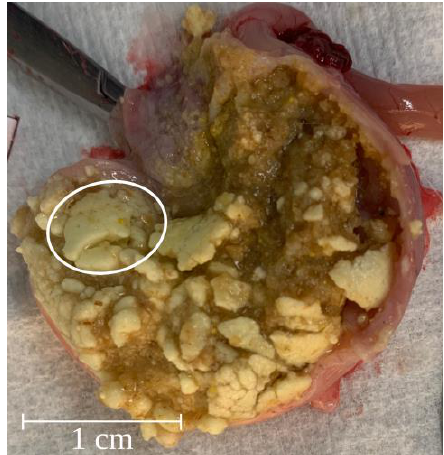
Figure 7. At scheduled necropsy opened rat stomach of a male rat of DF 1 with multiple small to medium-sized pharmacobezoars accompanying the encircled major pharmacobezoar.